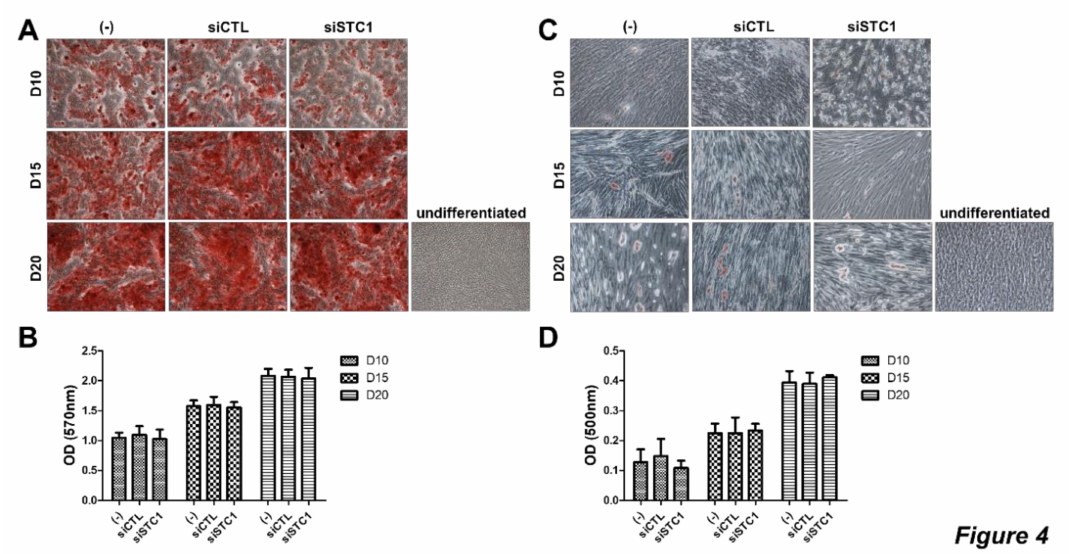
Figure 4. Di ff erentiation of TMSCs after STC1 inhibition. Di ff erentiation of TMSCs was evaluated by specific staining after STC1 inhibition ( A – D ). Osteogenic di ff erentiation was induced in untreated or siCTL- and siSTC1-treated TMSCs and stained by Alizarin red S at day 10, 15, and 20, followed by the elution for quantification ( A , B ). Adipogenic di ff erentiation was induces in TMSCs and stained with Oil Red O at day 10, 15, and 20, followed by the elution for quantification ( C , D ). Results are three technical replicates of TMSC from one donor. Representative results from two di ff erent TMSCs with similar tendency were presented. Results are shown as mean ±